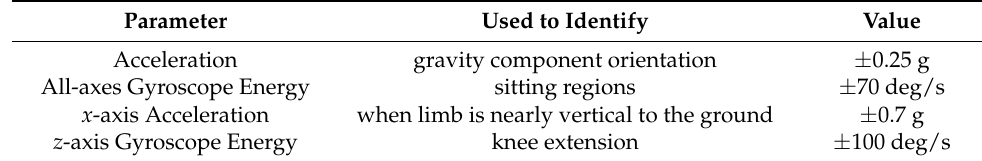
Table 1. Handcrafted parameters for the extraction of features of the presented algorithm. Parameter Used to Identify Value Acceleration gravity component orientation ± 0.25 g All-axes Gyroscope Energy sitting regions ± 70 deg/s x -axis Acceleration when limb is nearly vertical to the ground ± 0.7 g z -axis Gyroscope Energy knee extension ± 100